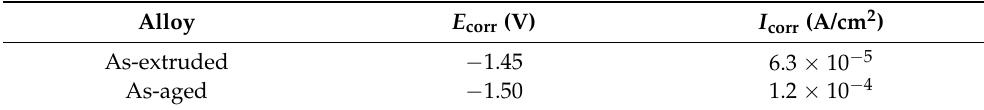
Figure 7. Polarization curves of the Mg–6.0Gd–1.2Cu–1.2Zr alloy in 3 wt.% KCl solution. Table 3. Electrochemical parameters of the Mg–6.0Gd–1.2Cu–1.2Zr alloy obtained using Tafel extrapolation from Figure 7.